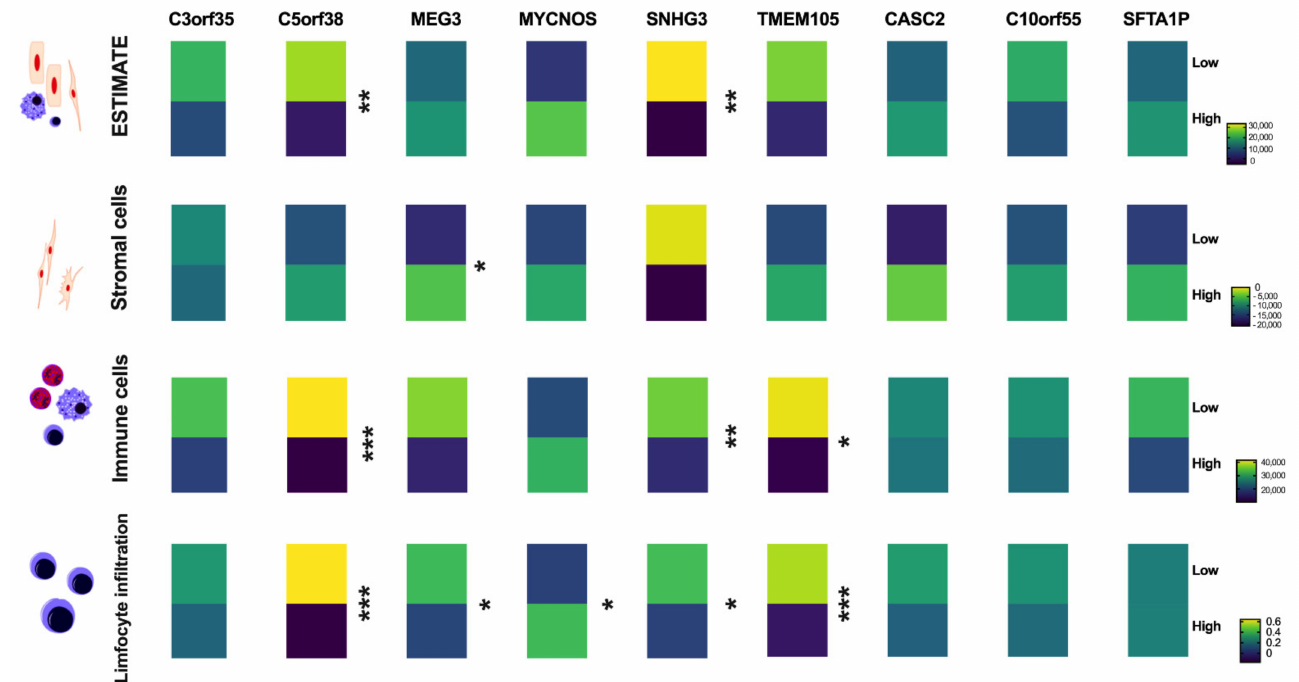
Figure 5. Analysis of infiltration of immune cells into tumor tissues and inference of the tumor purity depending on the expression level of CASC2, C10orf55, and SFTA1P; Student t -test or Mann-Whitney